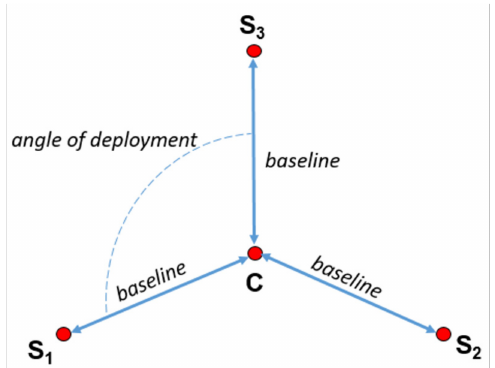
Figure 6. General four-position MLAT system